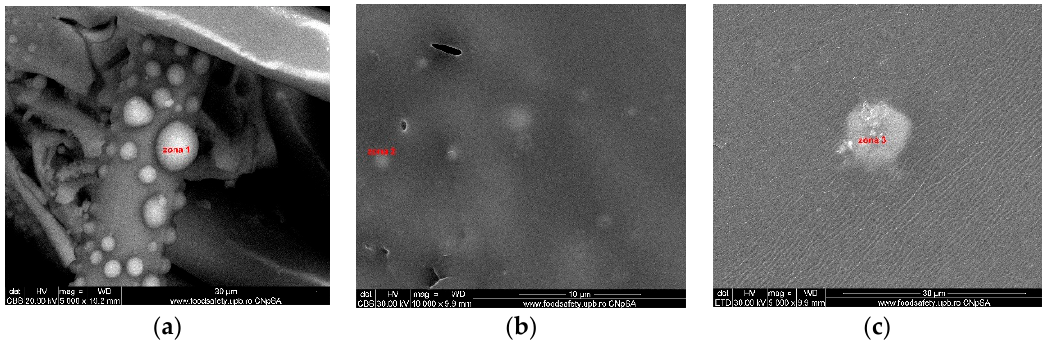
Figure 6. SEM images of microfiber composite membranes: ( a ) Surface of titanium dioxide spherical decoration, ( b ) microfiber surface, and ( c ) top surface of the membrane.